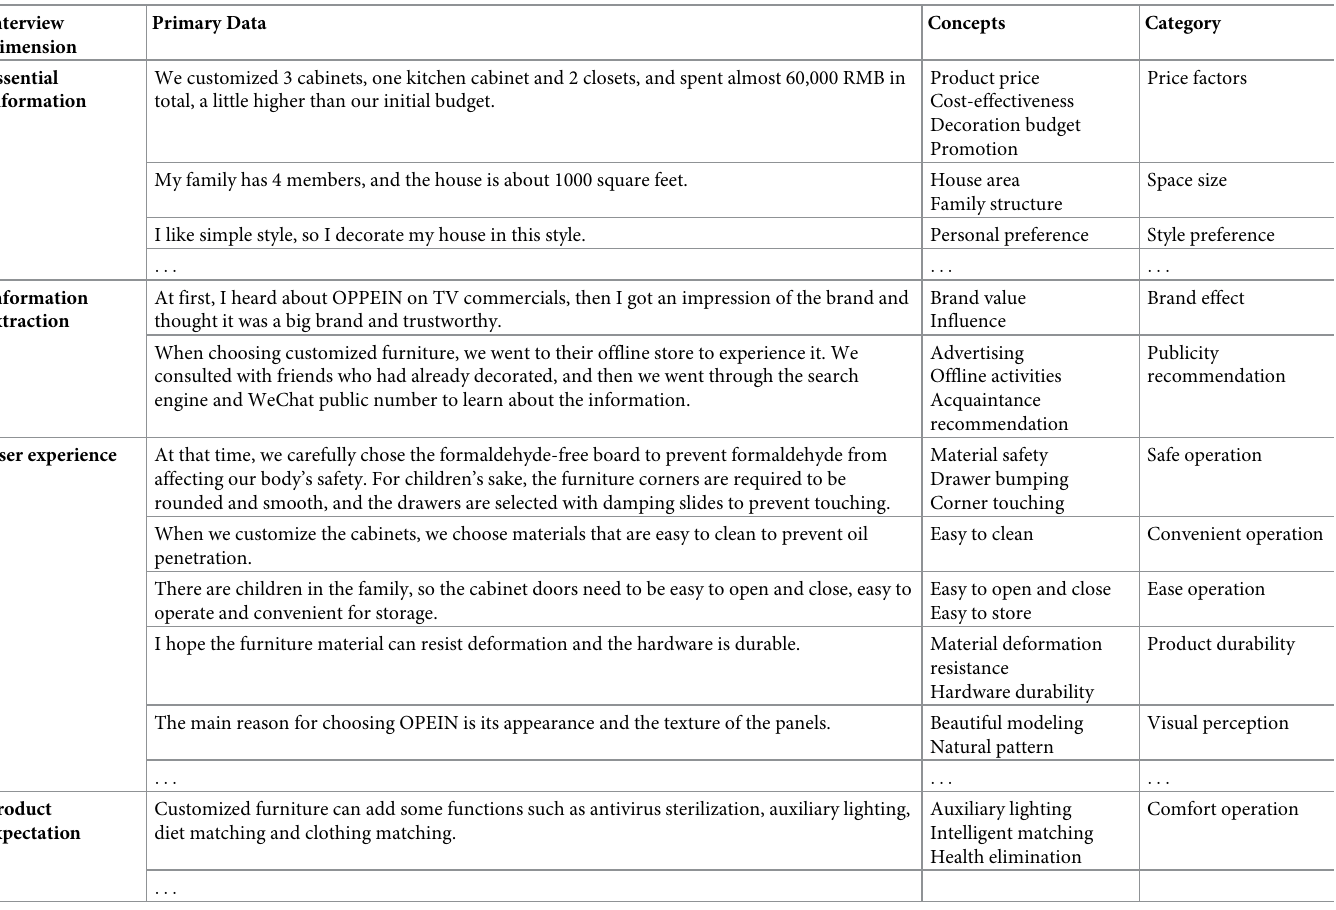
Table 2. Partial open coding